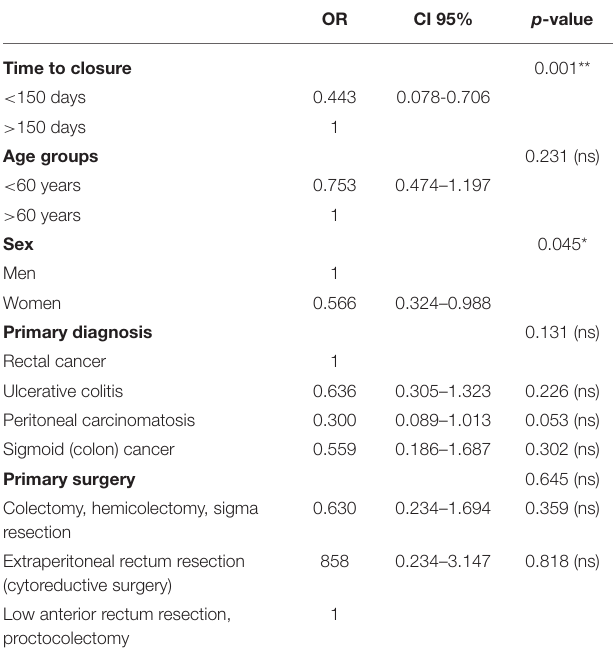
TABLE 3 | Univariate analysis of risk factors in complications after closure of the protective loop-ileostomy.